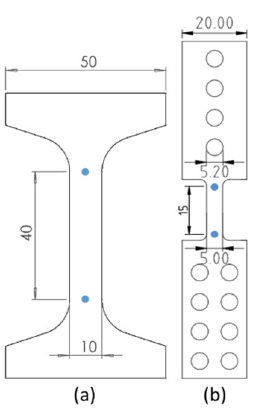
Fig. 1. Specimen geometries for (a) low, intermediate, and (b) high strain rate testing. The blue dots mark positions of extensometers for global displacement measurements through